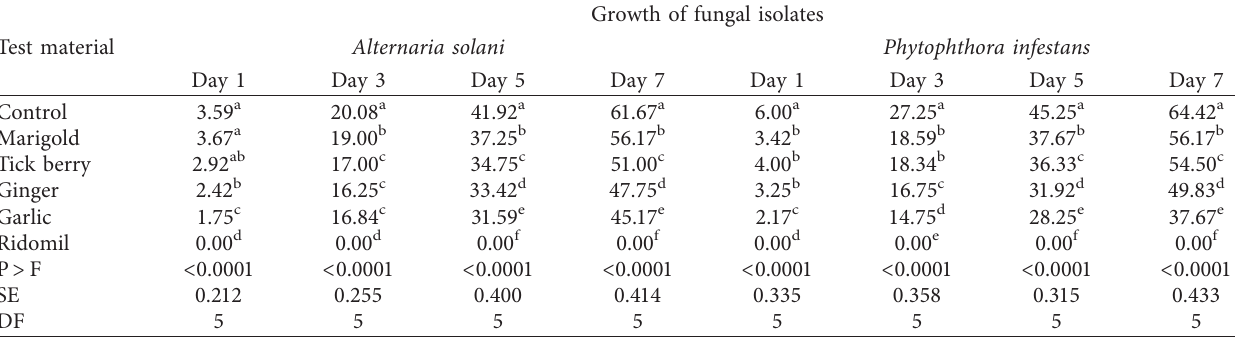
Table 1: Antimicrobial activity of water-extracted plant extracts on the growth of the fungal pathogens. Test